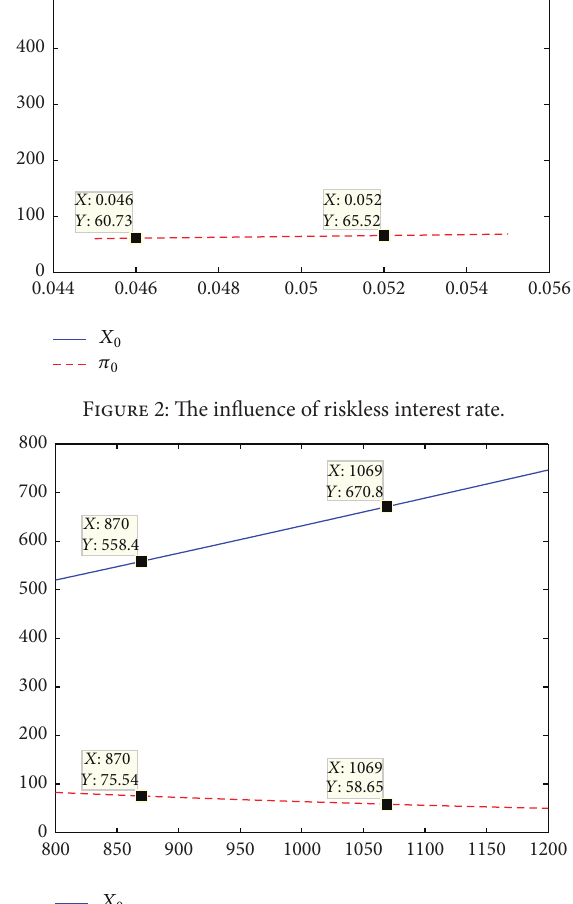
Figure 3: The influence of face